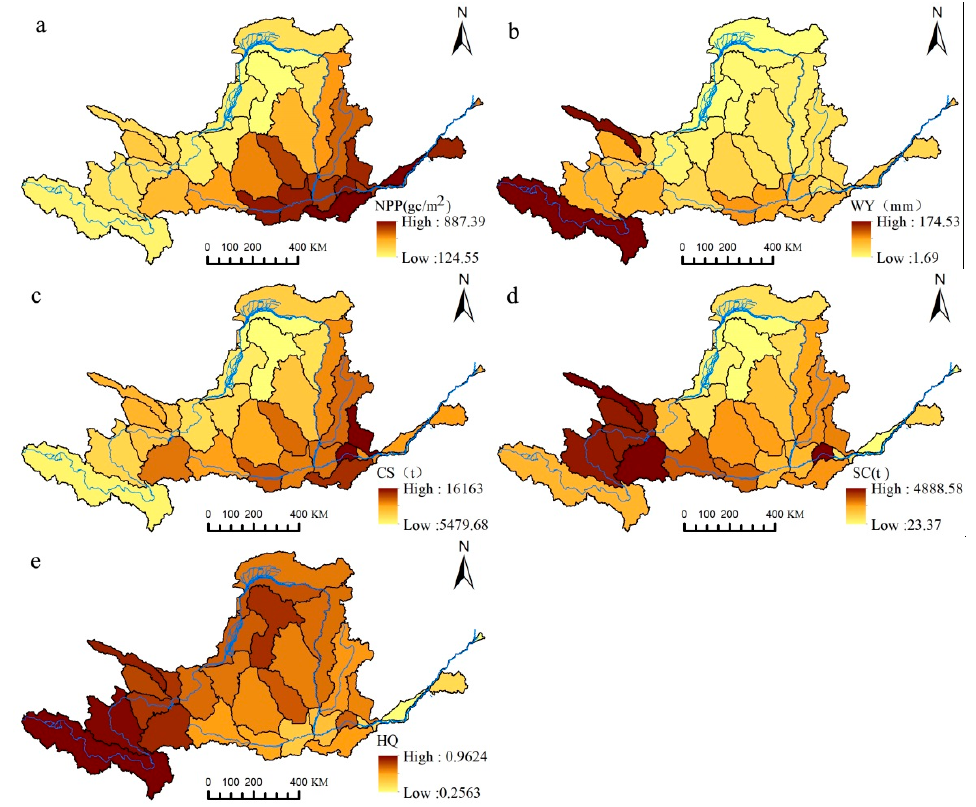
Figure 3. Spatial distribution map of ESs in the Yellow River Basin. ( a : NPP; b : WY; c : CS; d : SC; e : HQ).